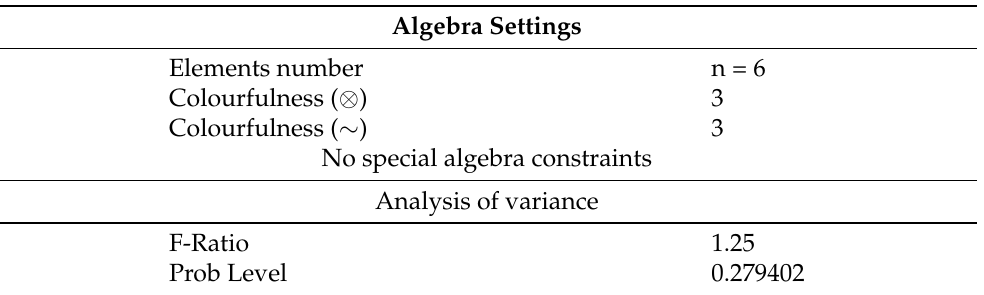
Table 1. Experiment no. 1.